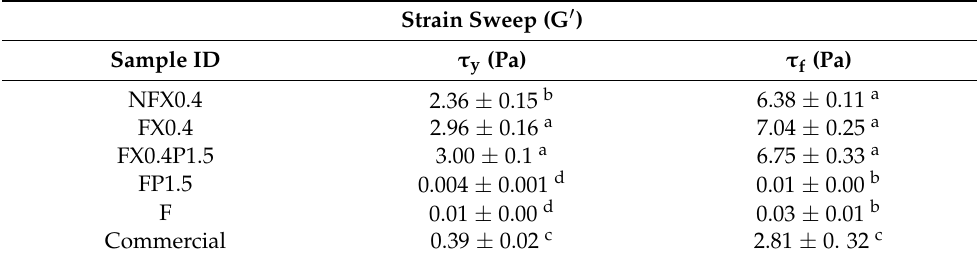
Table 8. Strain sweep test values for samples. Data are presented as mean values of triplicates ± standard deviation. The third sample of FP1.5 was excluded. Means values not connected by same letters are significantly